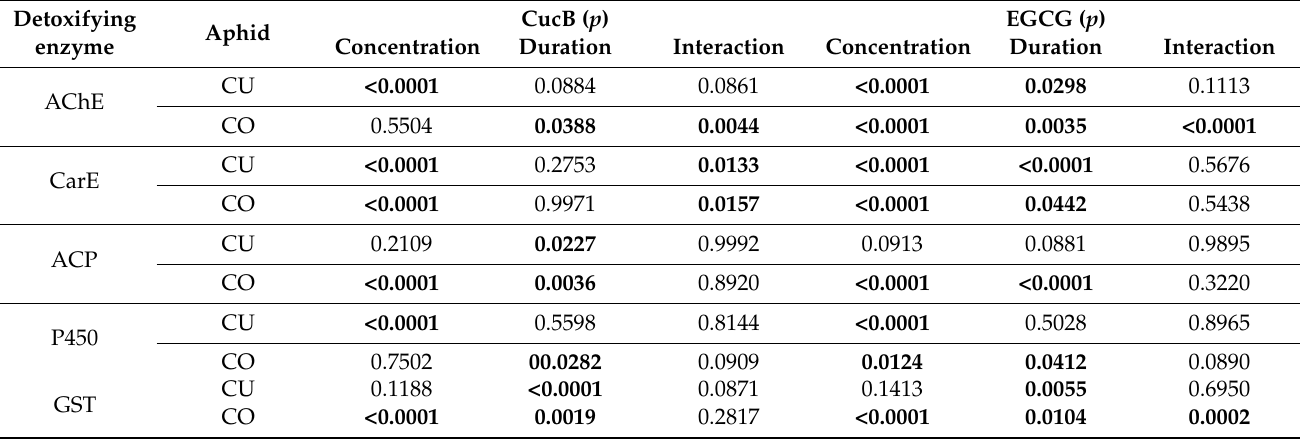
Table 5. Effects of concentration and the duration exposure of CucB on EGCG on detoxifying enzyme activities. Detoxifying